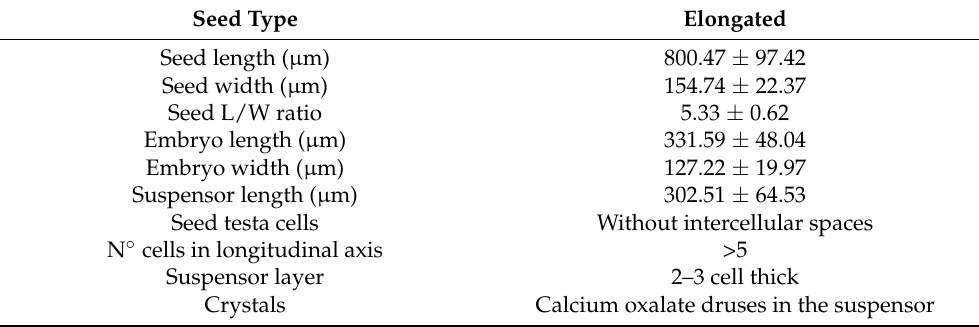
Figure 1. Light microscopy images of Cattleya purpurata seed. ( a ) LM overview of NaClO-treated seed, in which embryo is well distinguishable within the seed coat; ( b ) detail of the embryo body-suspensor connection (arrow) composed of 2–3 elongated cells. ( c ) untreated seed: view of the insertion of the suspensor inside the micropyle. Spherical druses are present in each cell of the suspensor (arrow). Table 2. Means of seed morphological parameters ( n = 100) and seed features of Cattleya purpurata (±Standard Deviation).